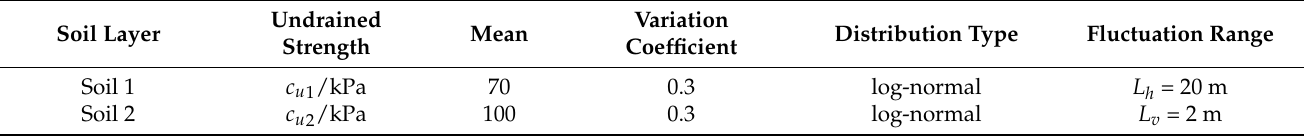
Figure 8. Heterogeneous slope calculation model. Table 5. Statistics of soil parameters.